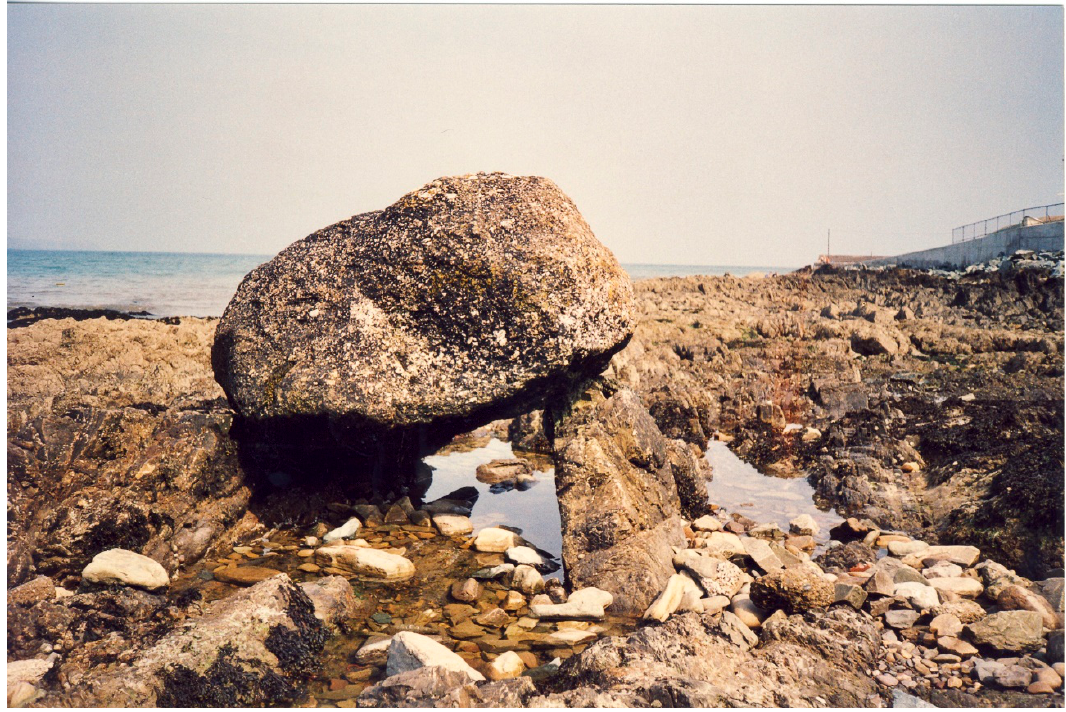
Figure 10. St. Kevin’s Stone,